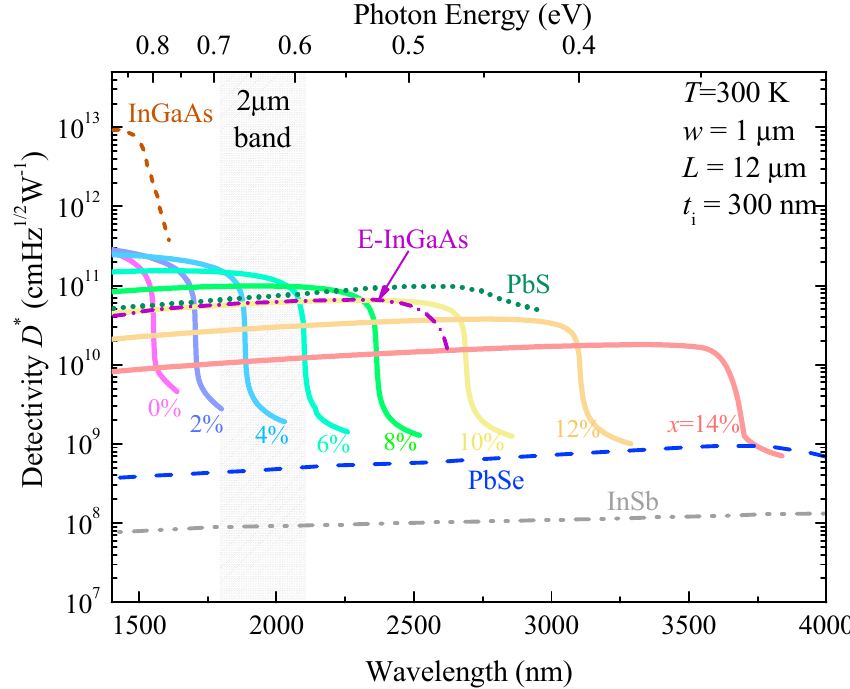
Figure 12. Calculated detectivity spectra of GeSn waveguide photodetectors with different Sn concentrations compared with selected SWIR and MIR PDs.